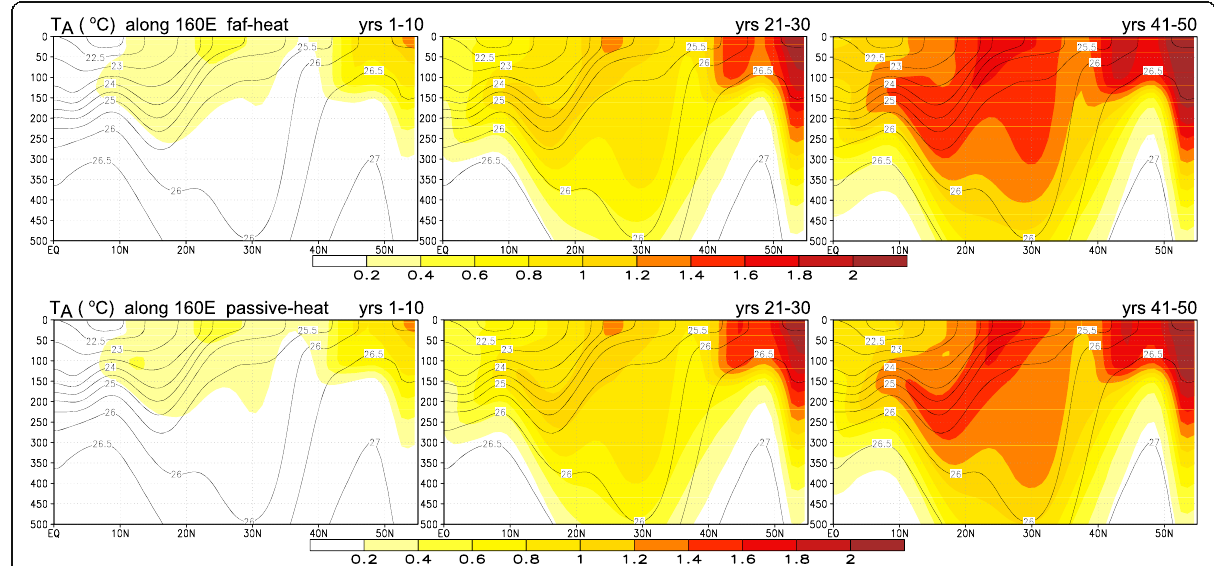
Fig. 5 Time march of latitude-depth sections of the added heat tracer T A (°C) along 160° E for the first decade, the third decade, and the fifth decade for the faf-heat experiment (upper panels) and the passive-heat experiment (lower panels). Contours indicate the potential density (kg m − 3 ) in piControl